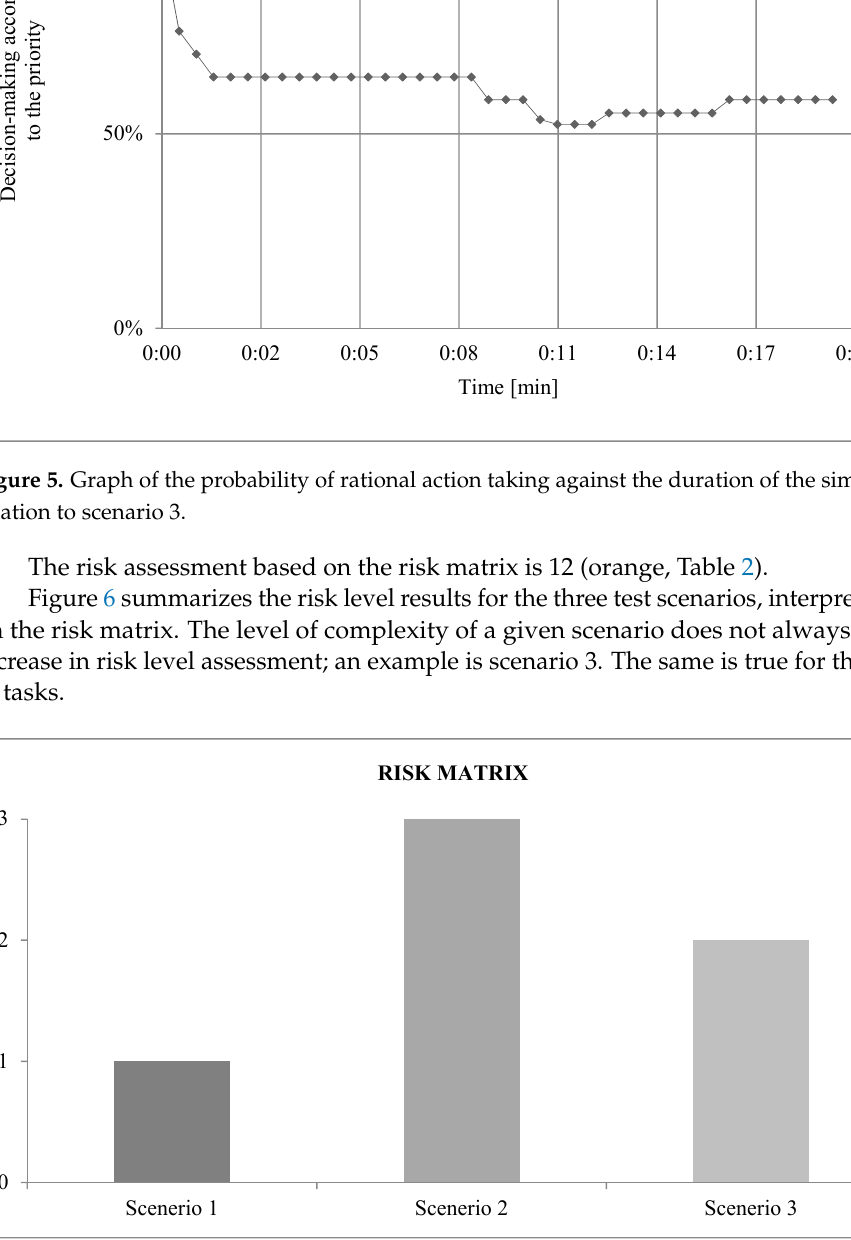
Figure 6. Assessment of the risk level of the test scenarios.